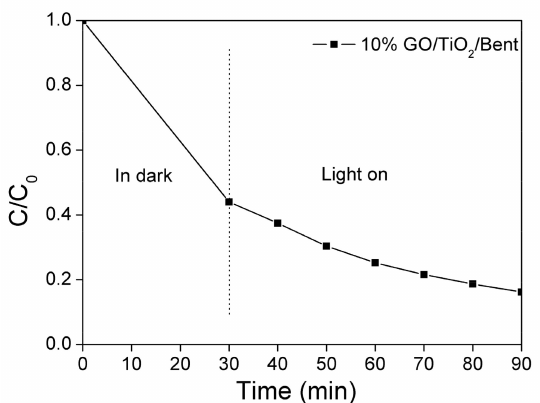
Figure 7. Removal rate of MB in solution with a higher concentration by 10% GO / TiO 2 / Bent (Concentration of MB: 100 mg / L in100 mL MB solution; Mass of 10% GO / TiO 2 / Bent: 50